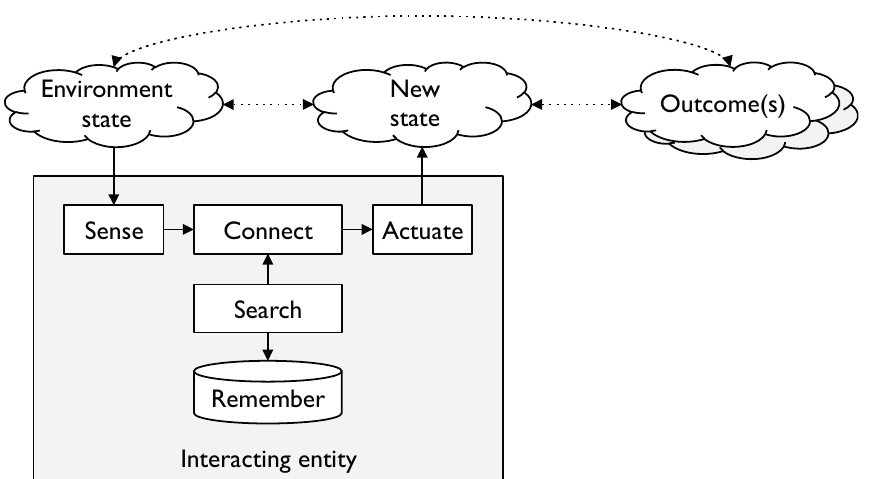
Figure 1. A generic Interacting Entity (IE)